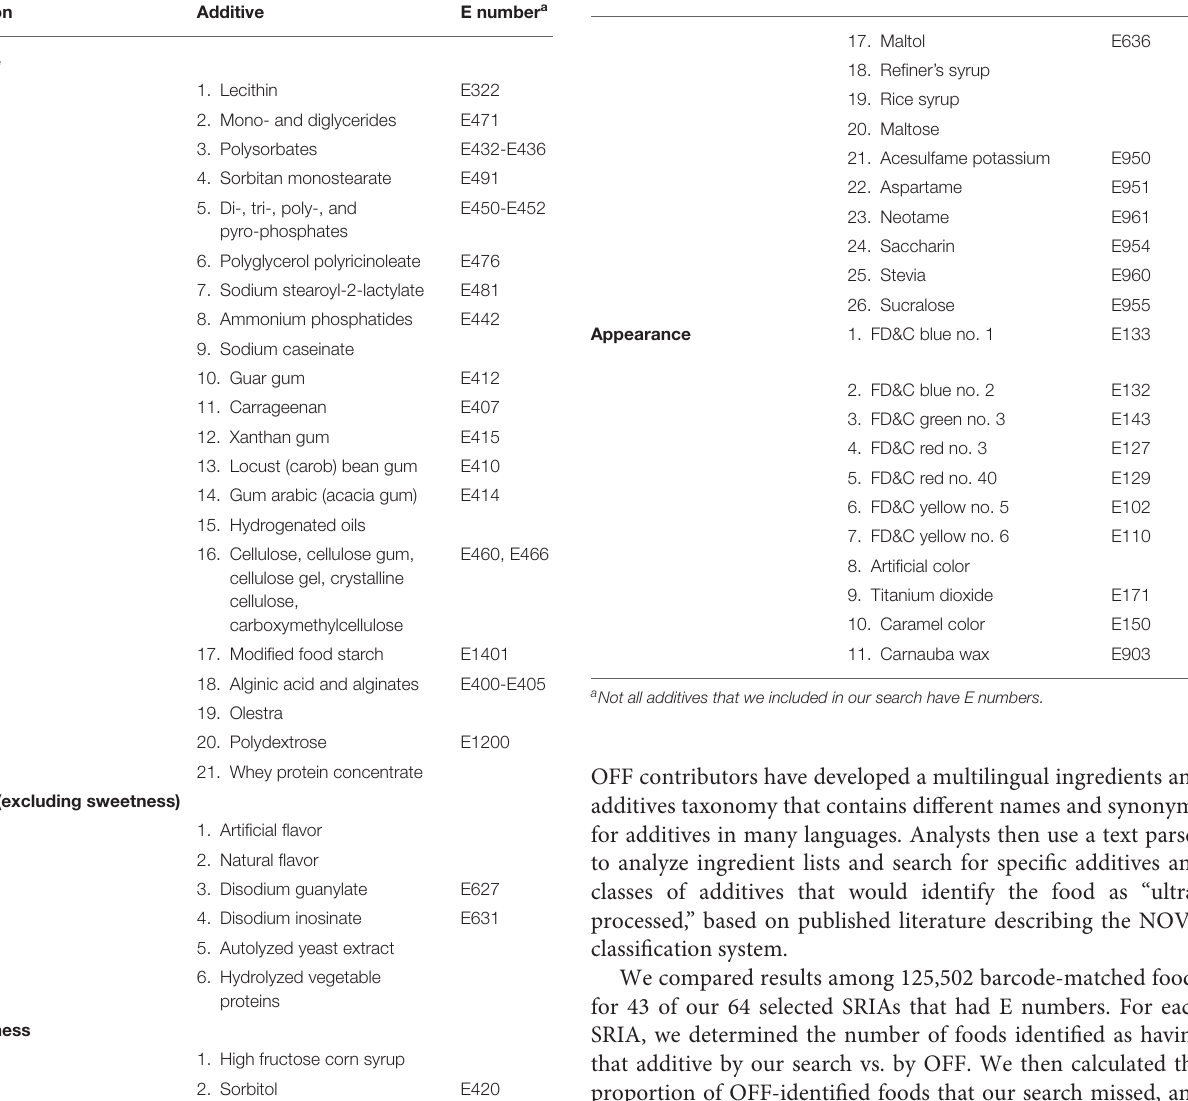
TABLE 1 | List of sensory-related industrial additives (SRIA) sought in ingredient lists. Function Additive E number a